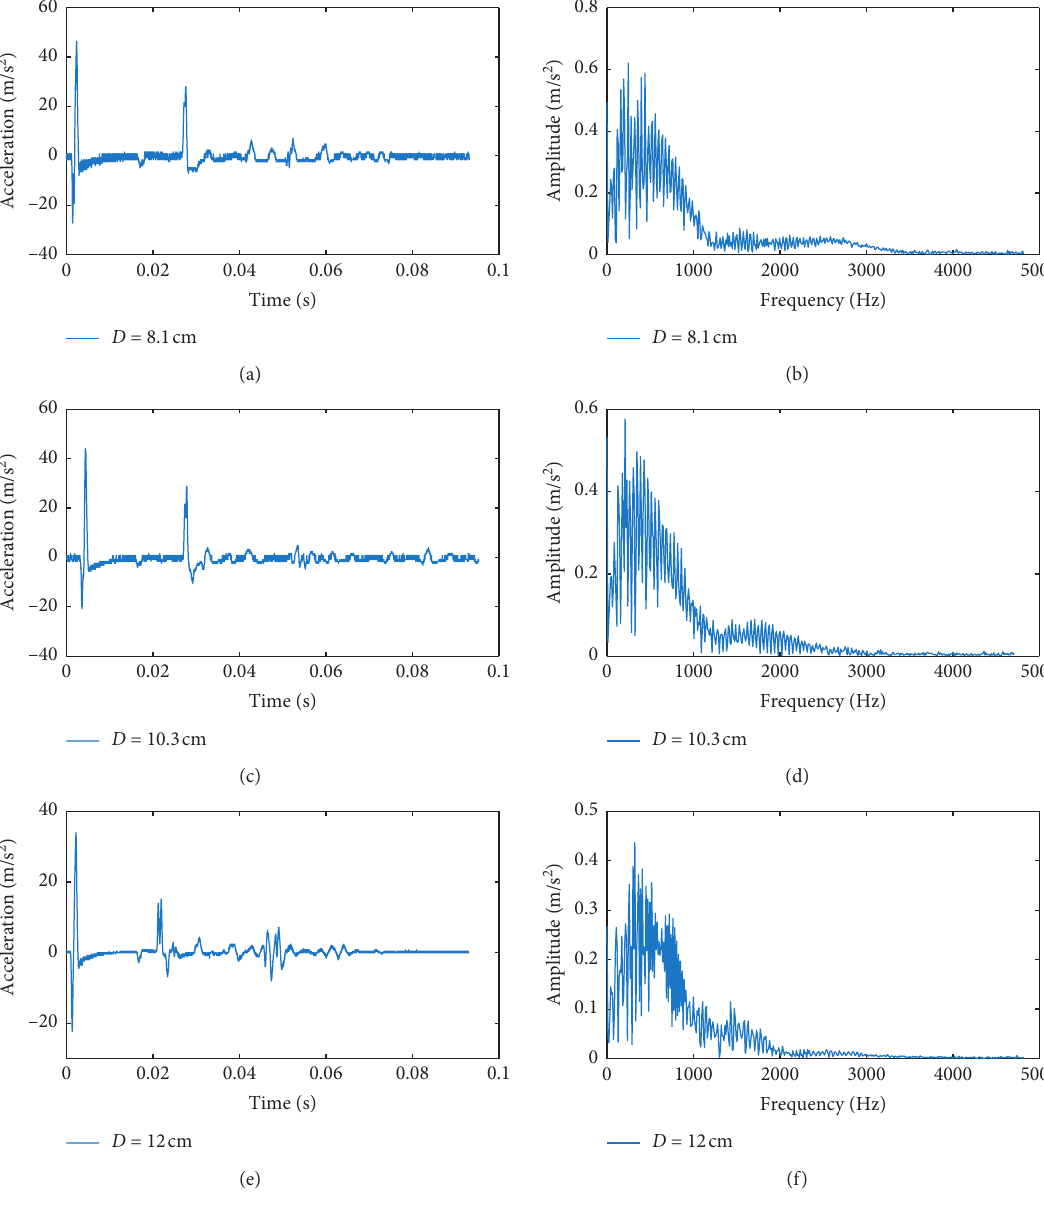
Figure 10: (a, c, e) Time-domain waveforms and (b, d, f) frequency spectra for different Teflon